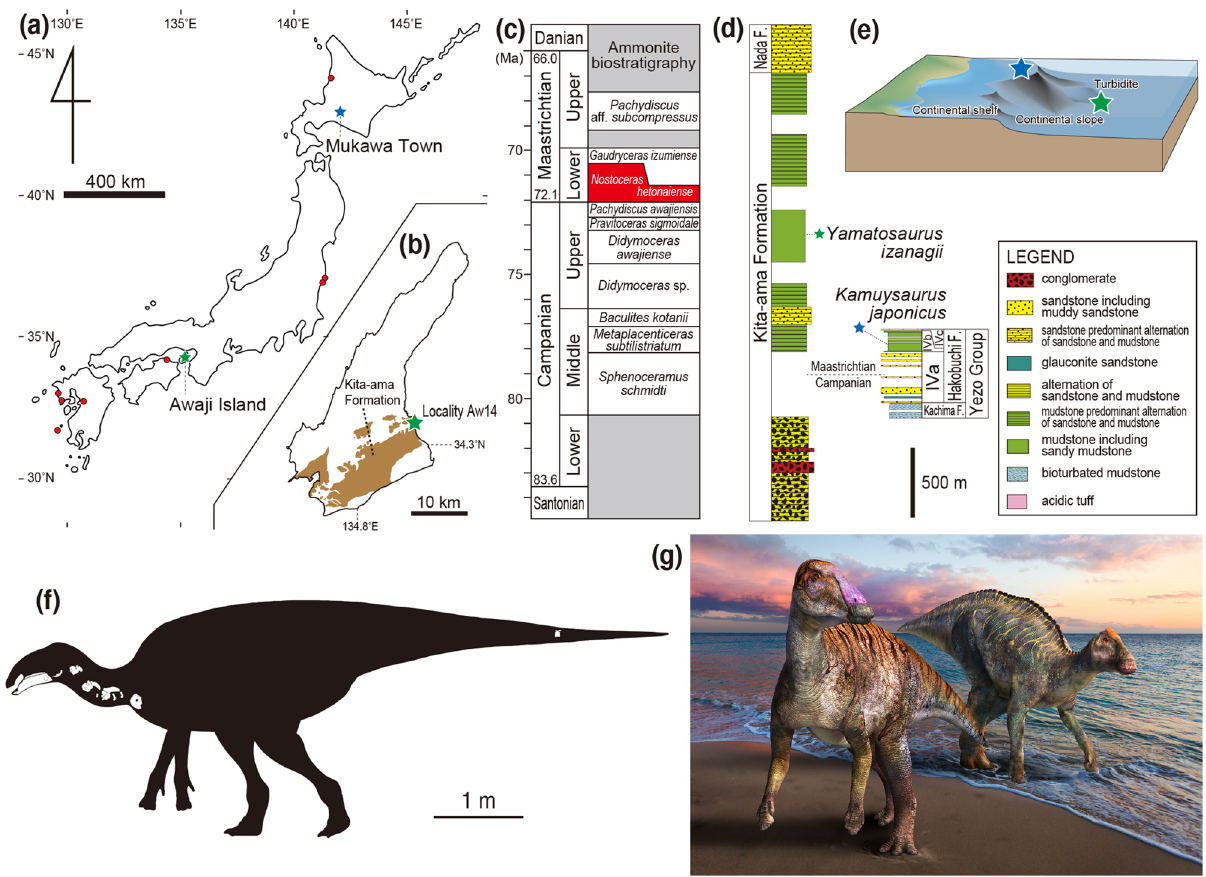
Figure 1. Map of Japan, showing the localities of Yamatosaurus izanagii gen. et sp. nov. on Awaji Island (green star), Kamuysaurus japonicus in Mukawa Town (blue star), and other Late Cretaceous hadrosauroids (red circles) ( a ) and the location of Locality Aw14 on Awaji Island ( b ). Ammonite biostratigraphy, showing the position of the Nostoceras hetonaiense Zone ( c ). Stratigraphic sections of the Kita-ama and Hakobuchi formations ( d ) and depositional environments of Yamatosaurus izanagii (green star) and Kamuysaurus japonicus (blue star) ( e ). Note that ( d ) differs from Fig. 1 of Tanaka et al. 27 because we corrected errors, including the scale and the stratigraphic boundaries between the Kita-ama and Noda formations and between the Campanian and Maastrichtian. Silhouette of Yamatosaurus izanagii , showing recovered skeletal elements ( f ) (Courtesy of Genya Masukawa). Life reconstruction of Yamatosaurus izanagii (left) and Kamuysaurus japonicus (right) ( g ) (Courtesy of Masato Hattori). ( a ) and ( b ) were created by one of the authors of this paper, Katsuhiro Kubota, by using Adobe Illustrator 2021 (https:// www. adobe. com/ produ cts/ illus trator.